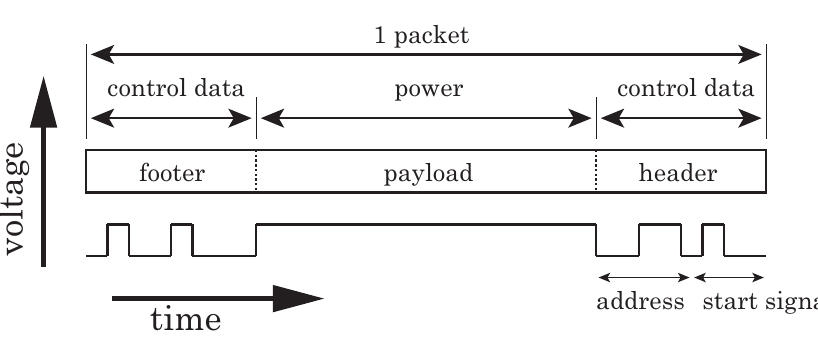
Figure 1. Structure of the power packet.